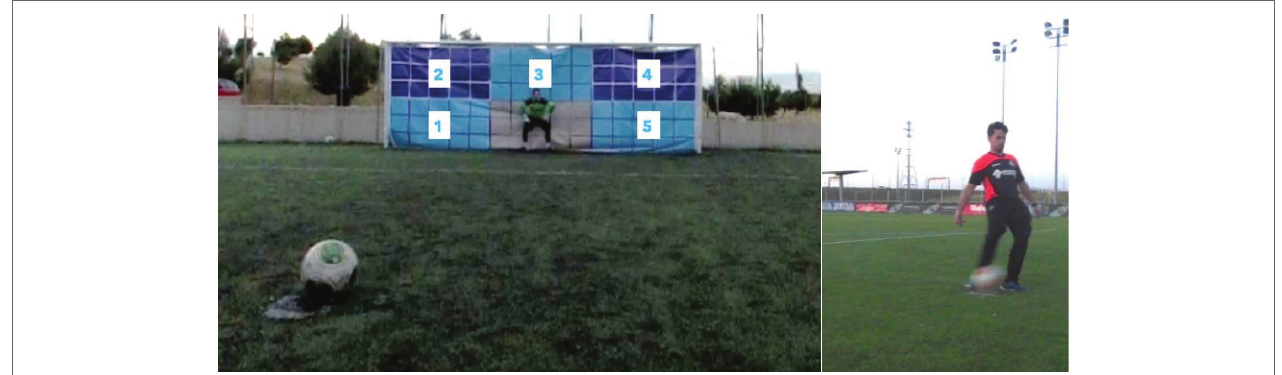
FIGURE 1 | Set up of the experiment depicting the perspective of the goal (left) and the penalty takers